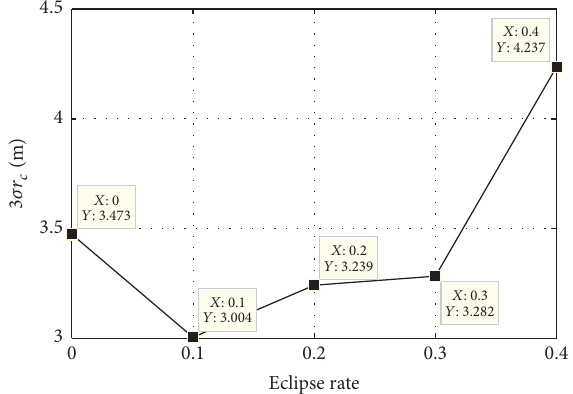
Figure 6: Eclipse rate influence on final relative position control error.